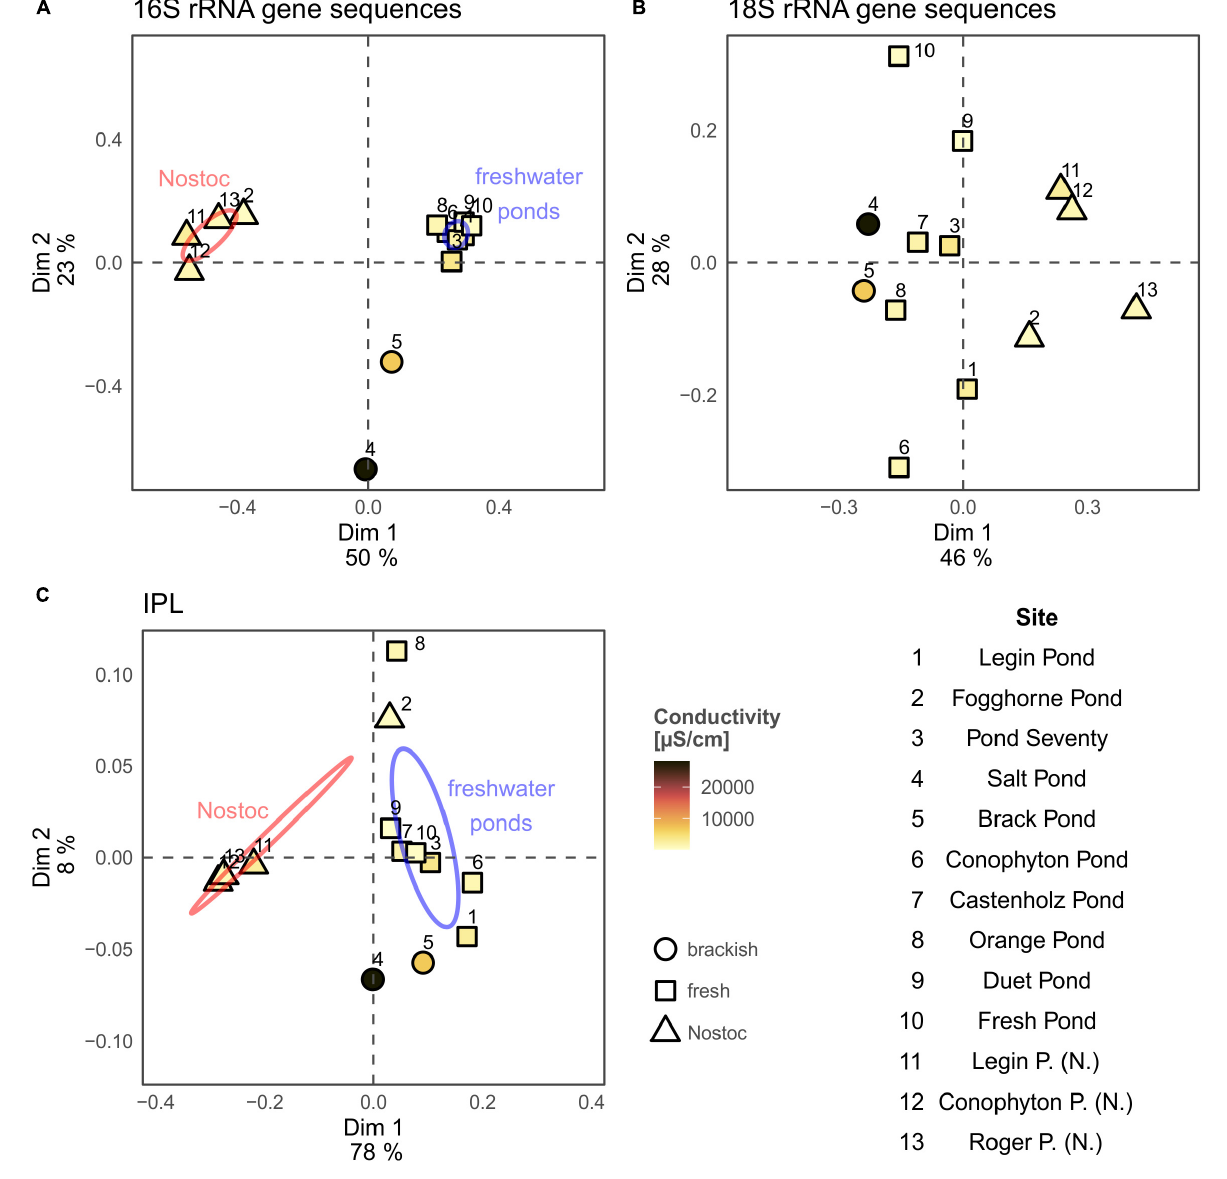
FIGURE 3 | Principal coordinates analysis (PCoA) of the 16S rRNA gene (A) and 18S rRNA gene community composition (B) and intact polar lipid analysis (C) from the microbial mats collected at the McMurdo Ice Shelf. Ellipses for Nostoc type samples (samples 2, 11, 13, and 14; red; see Table 1 ) and freshwater samples (blue; see Table 1 ) represent the 95% confidence interval and were calculated using build in function of the “vegan” package. Conductivity results are shown in Table 1 . Results from New Pond and Skua Pond were excluded from the PCoA analysis due to missing environmental (New Pond) and rRNA gene sequence data (Skua